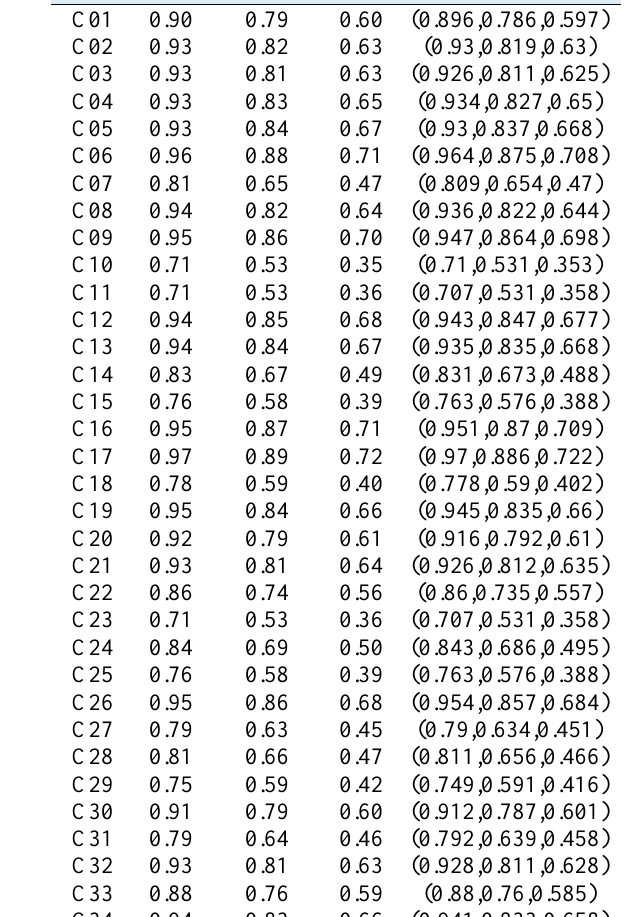
Table 5. The Fuzzy mean of the panel of experts for each of the research indicators Code